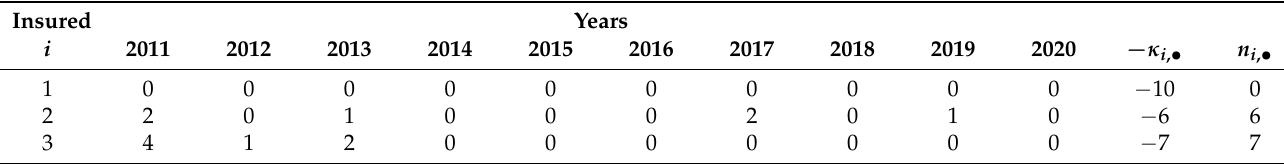
Table 1. Insureds with claims experience.